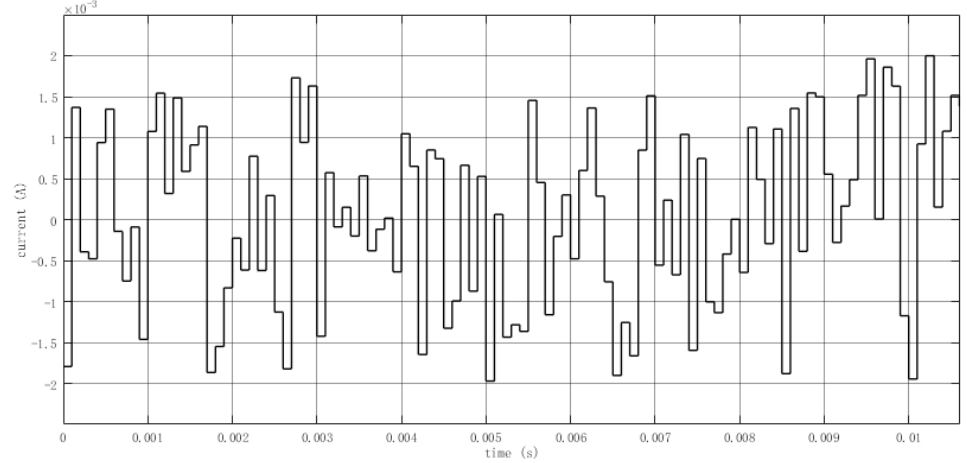
Figure 4. Schematic diagram of stimulus signal.